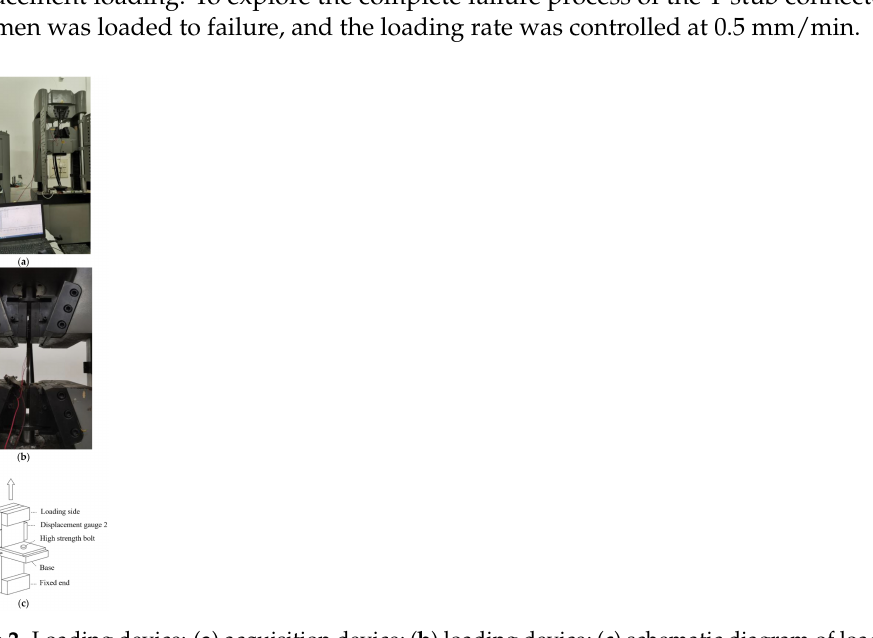
Table 2. Material property test results.